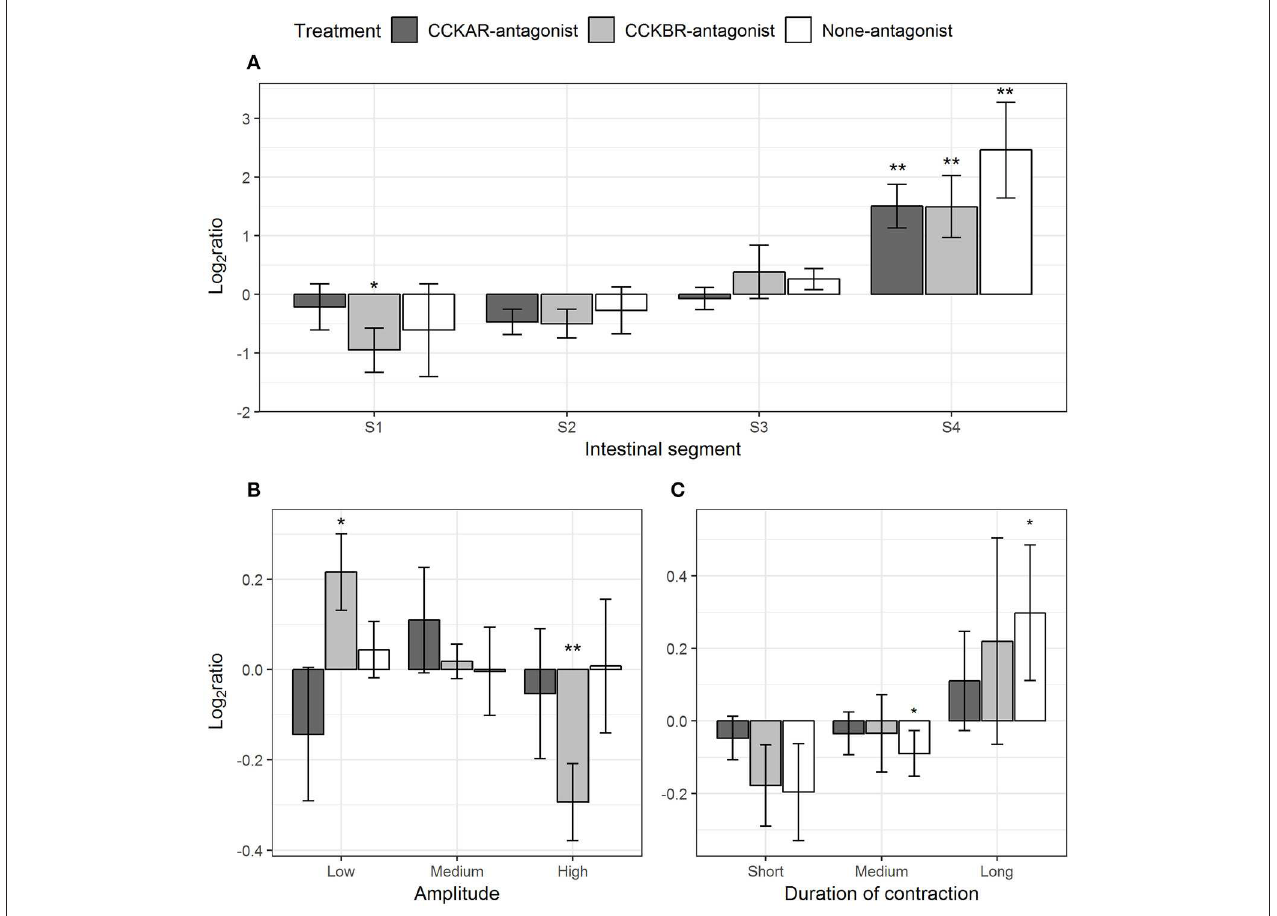
FIGURE 9 | Effect of CCK-8S with presence of CCK-receptor antagonists on standing contractions. CCKAR-antagonist: intestines were pre-incubated with devazepide, CCKBR-antagonist: intestines were pre-incubated with L-365260, and None-antagonist: intestines were pre-incubated with DMSO as a control prior to exposing intestine to CCK-8S. The three plots show log 2 of ratios of contraction parameters recorded after to before exposing intestine to CCK-8S: (A) for frequency of standing contractions measured in four intestinal segments (S1, S2, S3, and S4); (B) for proportion of standing contractions which had a low, medium or high amplitude; (C) for proportion of standing contractions which prolonged for a short, medium, or long duration. Bars are presented with mean ± SEM ( n = 4 for CCKAR-antagonist, n = 5 for each CCKBR-antagonist/none-antagonist). Asterisk (*) denotes the statistically significant differences of ratio values compared with 0 (one sample t -test, *for 0.05 ≤ p < 0.1 and ** p <